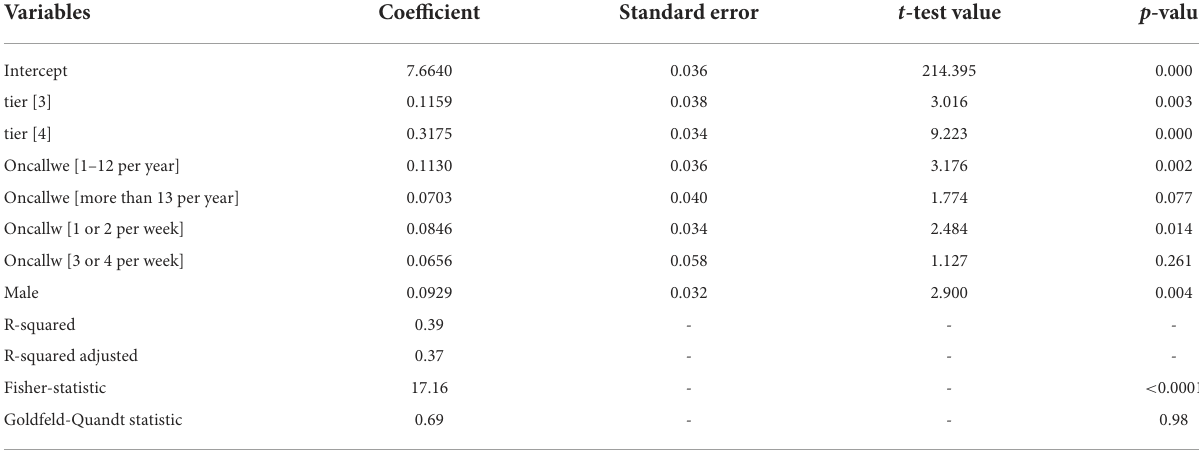
TABLE 2 OLS estimation of log wage (in euros) regression.